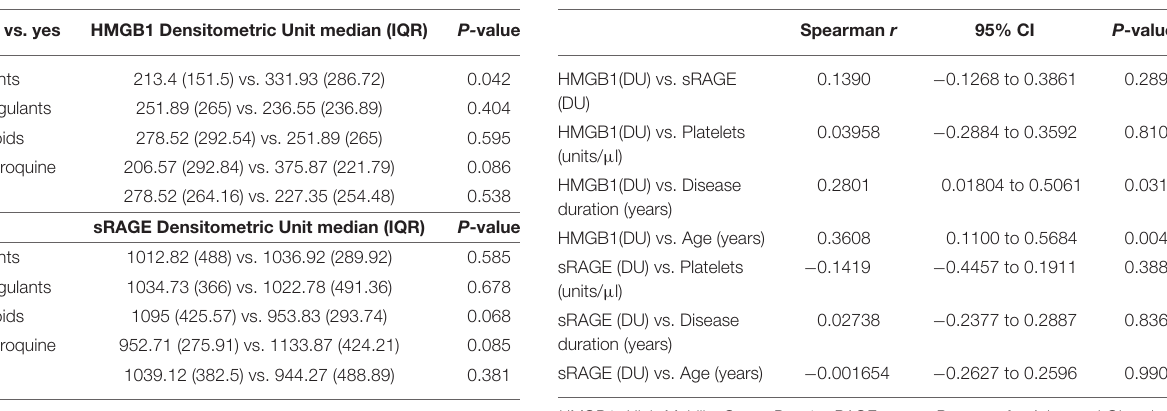
TABLE 3 | Univariate analysis with serum HMGB1 and